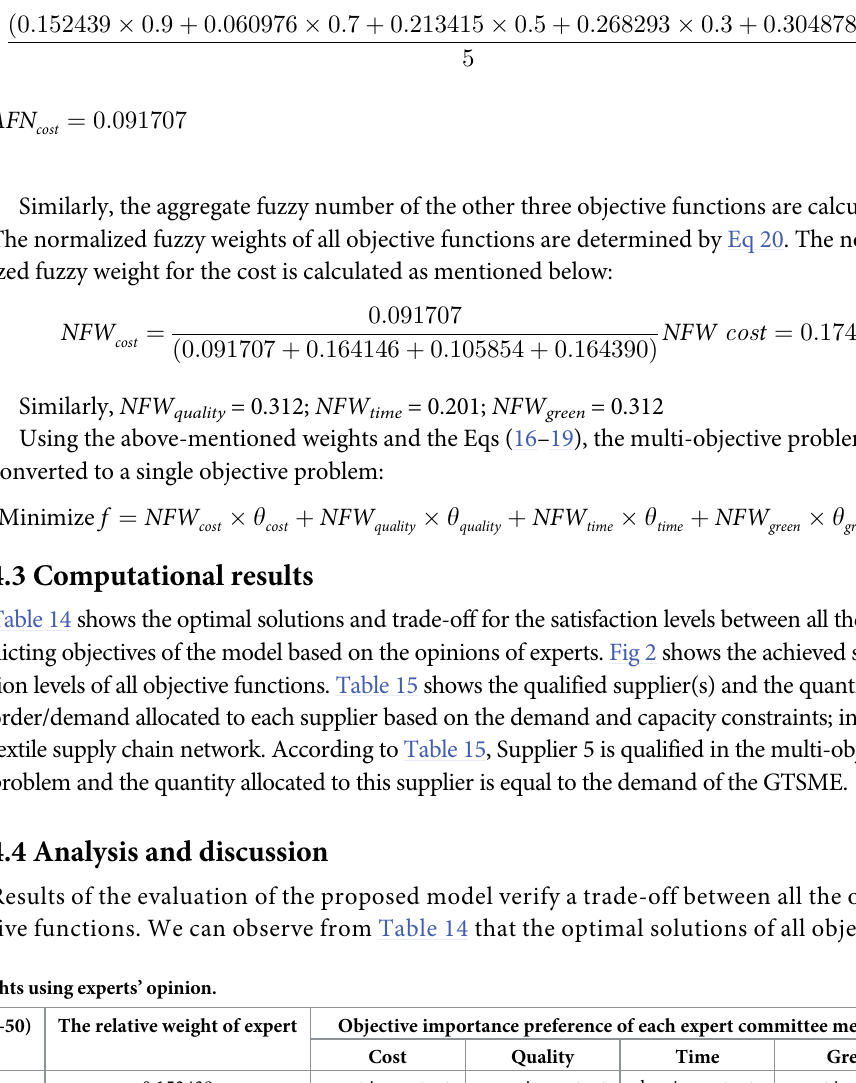
most important is 0.9 which is the average of (0.81, 0.9, 1). Using Eq 19, the aggregate fuzzy number of cost is calculated as shown below: